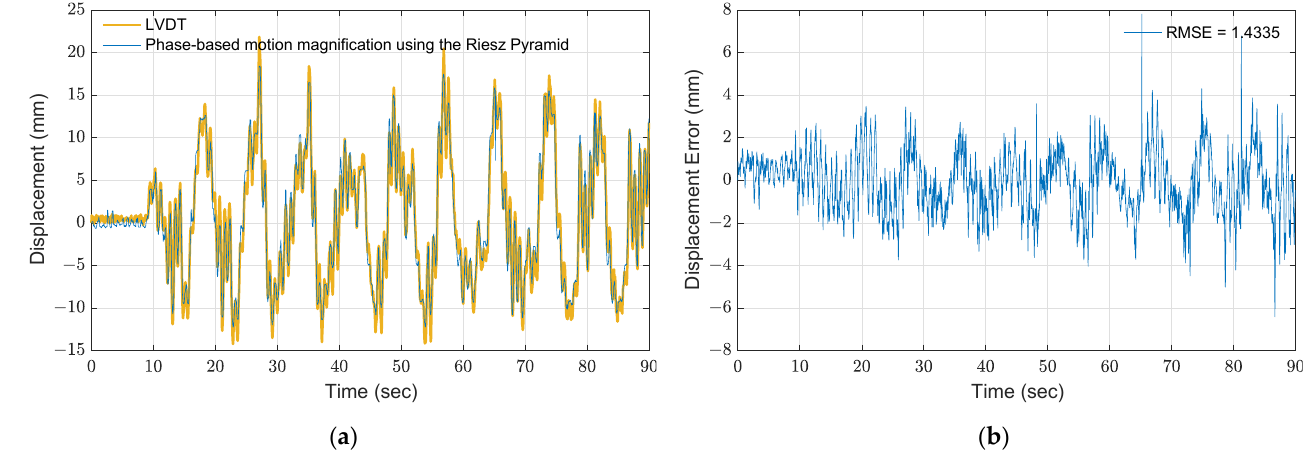
Figure 8. Results of phase-based motion magnification using the Riesz pyramid: ( a ) comparison between the proposed method with magnification factor of 5 and measurement from LVDT; ( b ) error.